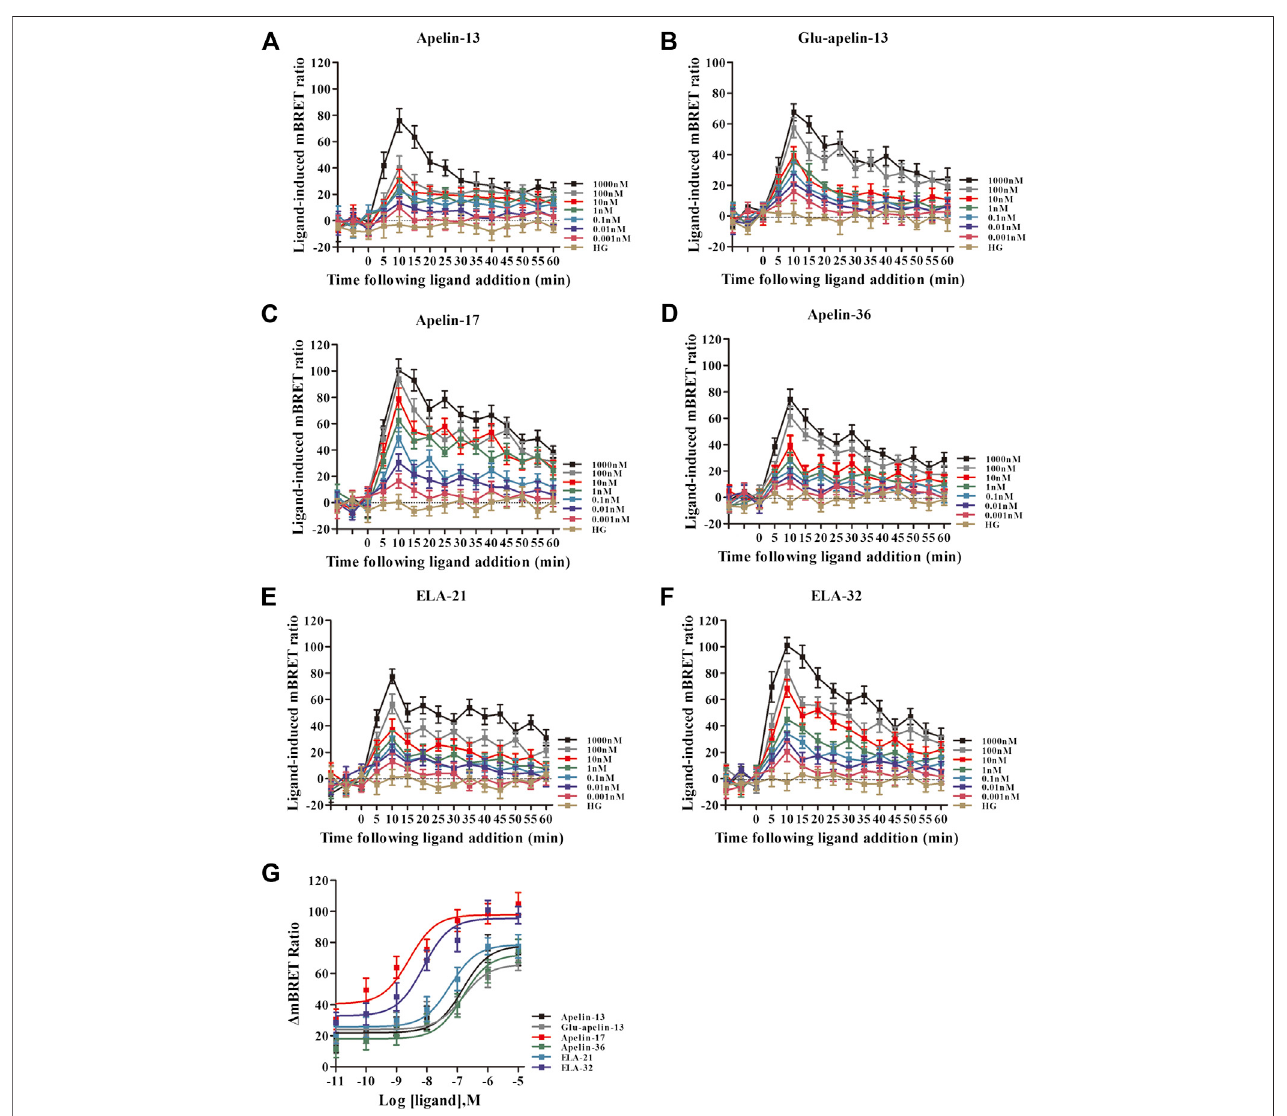
FIGURE5| Thetime-responsecurve( (A – F) forGRK5)anddose-responsecurve( (G) forGRK5)ofinteractionsbetweenAPJandGRK5inducedbythesixagonists of different concentrations, obtained from real-time dynamic BRET determination. p < 0.05 was considered as statistically signi fi cant. Control group (HG, Cells were stimulated with high glucose). With six peptides (G) stimulation, the dose-response curve of GRK5 recruited to APJ was measured by BRET (at 15 min). Data represent mean ± SEM from four independent experiments. Statistical analysis ( Supplementary Table S4 ).